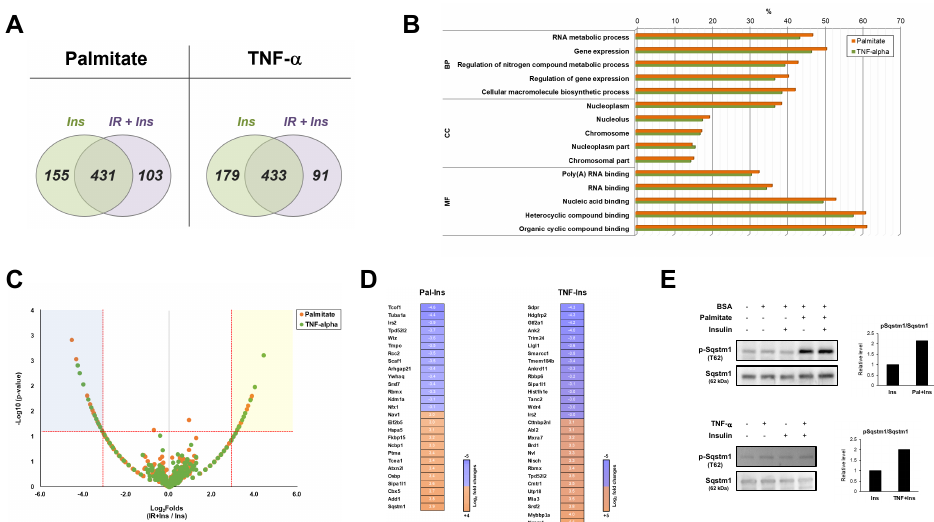
Figure 2. Phosphoproteomics of two different insulin-resistant conditions. ( A ) Venn diagram of the identified proteins. “Ins” and “IR + Ins” indicate the insulin-treated condition and insulin resis- tance then insulin-treated conditions, respectively. ( B ) Gene ontology (GO) enrichment analysis of two independent phosphoproteomes. “BP”, “CC”, and “MF” indicate biological process, cellular component, and molecular function, respectively. Significantly enriched GO terms are shown with the Benjamini–Hochberg false discovery rate-corrected percentage. ( C ) Volcano plot of significantly changed proteins of two independent phosphoproteomes. The − log 10 ( p -value) is plotted against the log 2 (fold change: IR + Ins/INS). The non-axial vertical lines denote a ± 3-fold change, whereas the non-axial horizontal line denotes p = 0.05, which is the significance threshold (prior to logarithmic transformation). ( D ) Heatmap representing the log 2 fold changes of significantly changed phospho- proteins under each insulin-resistance condition. The decreased and increased phosphoproteins are shown in blue and orange, respectively. ( E ) Western blot of the significantly changed phosphoproteins under each insulin-resistant condition. Conditioned cell lysates were electrophoresed and